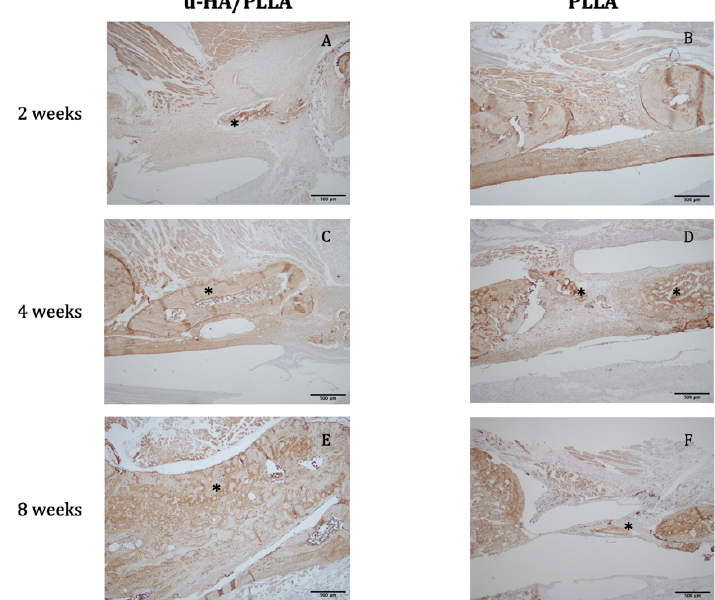
Figure 8. Expression of osteocalcin (OCN) in the ( A , C , E ) u-HA / PLLA and ( B , D , F ) PLLA groups. All photographs were taken at 4 × magnification. * New bone.